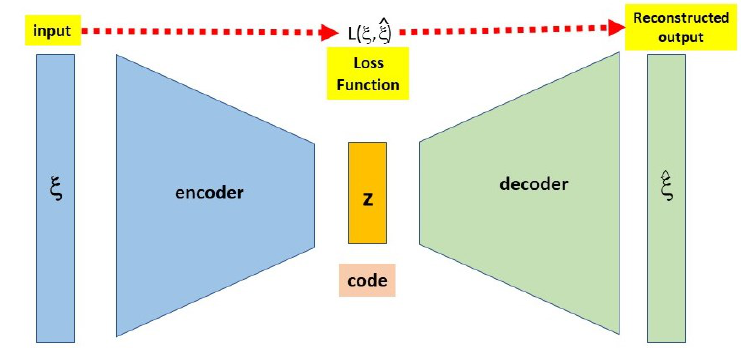
Figure 1. The autoencoder approach we adopt, where the input ξ is a encoded to a code z and then decoded to create the reconstructed input ˆ ξ . We use the loss function L ( ξ , ˆ ξ ) to control the quality of the